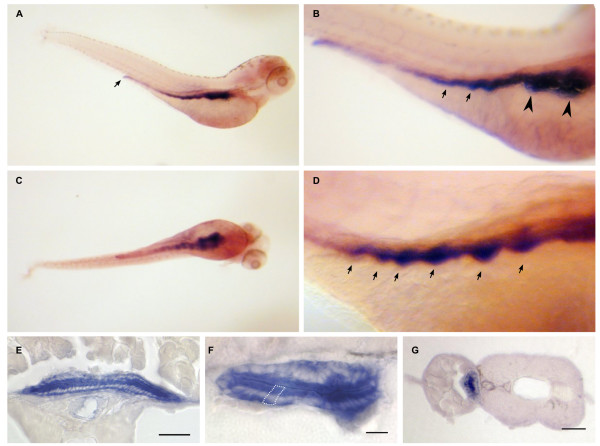
Dr-S100A10a expression pattern by whole mount in situ hybridization. Five day old zebrafish larvae were hybridized with RNA antisense probe. Panels A) to D), whole mounts; panels E) to F), sectioned after hybridization. Scale bars, 30 μm. A) Lateral view shows expression restricted to the whole intestinal tract including the anal region. B) Enlarged view, anterior is to the right, arrows point to the label in intestine. C) Ventral view, no other A10a-expressing regions are detected. D) Gut loops with high expression levels are pointed out by arrows. E, F) Cross sections of whole mount hybridizations at the level of the intestine. Only epithelial cells are strongly labeled, see white enclosure of a single epithelial cell in panel F). G) Gut epithelial cells are labeled as well.